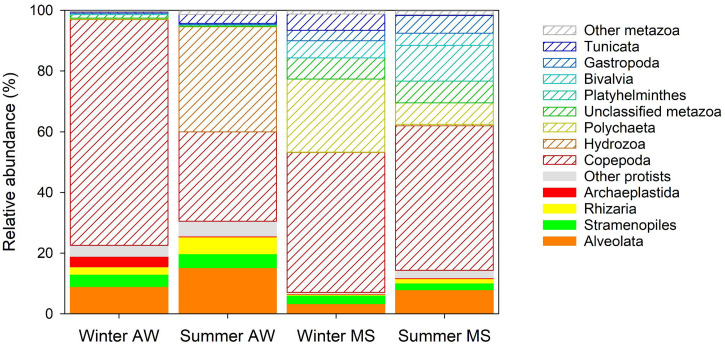
Averaged relative abundance of reads assigned to eukaryotes. The fraction of protists has color filling and the fraction of metazoa is shown as white bars with colored shading. Eukaryotic groups with lower relative abundance than 1% are grouped under “other protists” and “other metazoan.”